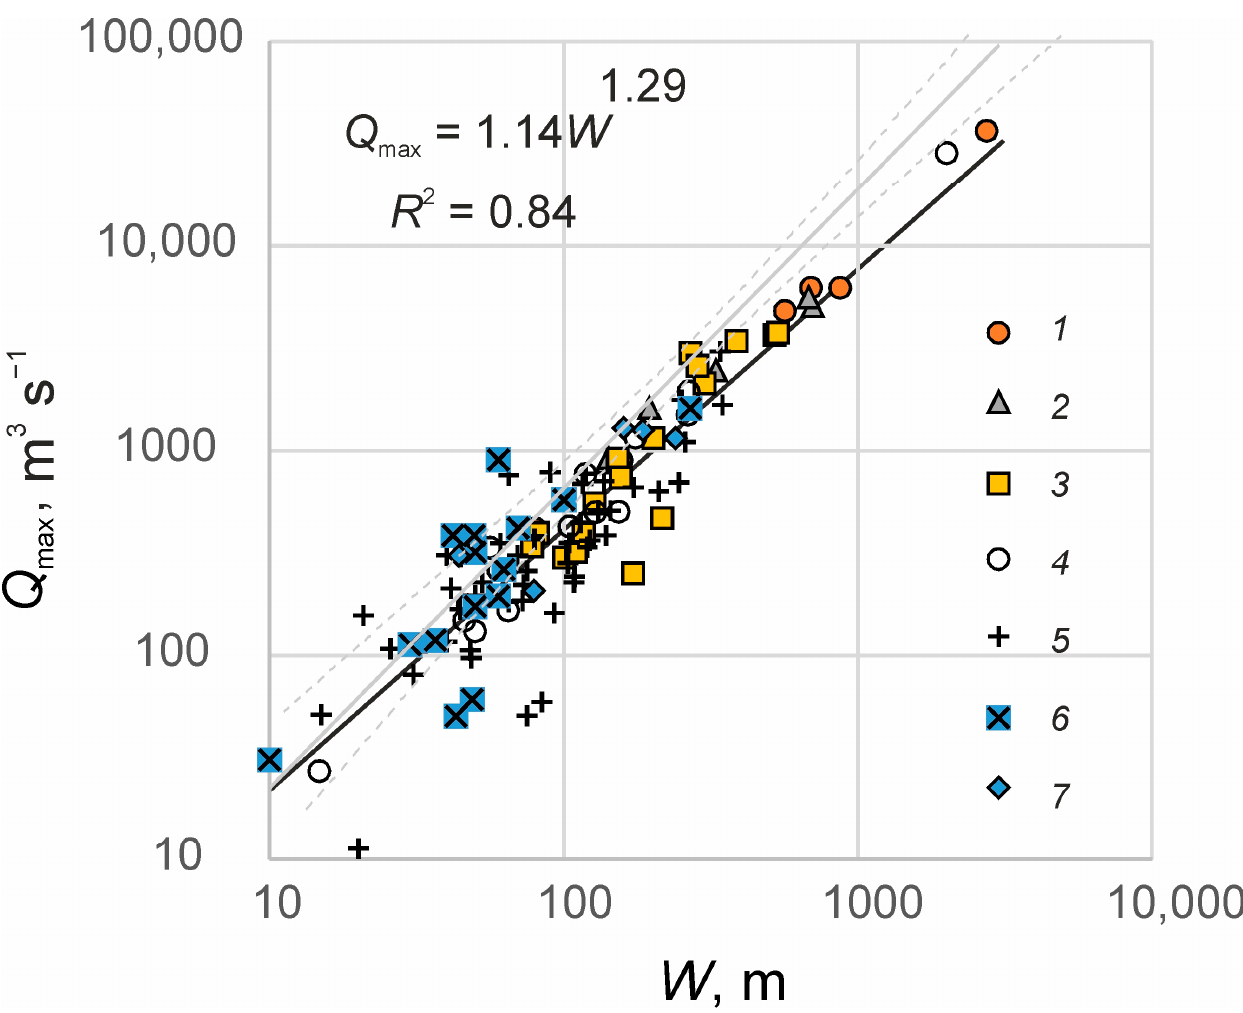
Figure 8. The relationship between channel bankfull width W and mean maximum discharge Q max for the rivers of West Siberia. Landscape zones: 1—tundra with continuous permafrost; 2—sparse forest (forest–tundra) with continuous permafrost; 3—northern taiga with discontinuous permafrost; 4—middle taiga with discontinuous permafrost; 5—middle and southern taiga; permafrost-free; 6—forest–steppe; 7—steppe. Gray solid line shows the relationship for the Lena River basin; dashed lines—95% confidence interval (see Figure 6).